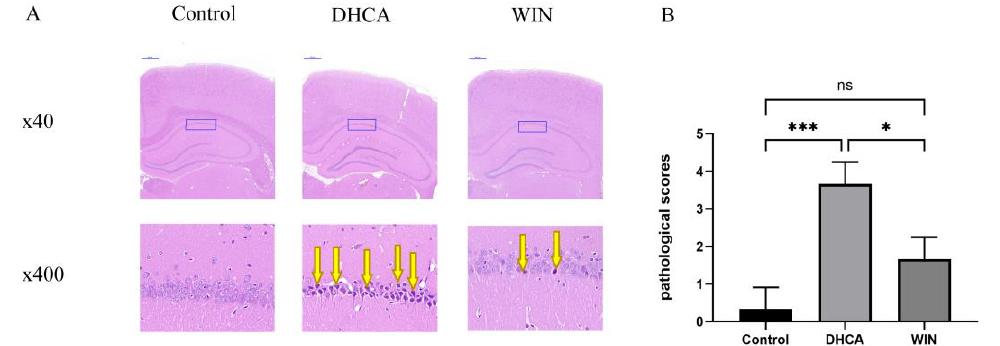
Figure 2. Hematoxylin – eosin staining showing the attenuation of hippocampal injury by WIN55, 212-2 in rats that underwent DHCA . ( A ) The blue boxes indicate the location of the hippocampus CA1 area. Neurons with pyknotic nuclei (yellow arrows) were decreased in the WIN55, 212-2-treated group. ( B ) Comparison of pathological scores of the hippocampus CA1. The region between the control, DHCA, and the WIN group ( n = 3). * p < 0.05, and *** p < 0.001. ns, no significance. DHCA, deep hypothermia circulatory arrest. CPB, cardiopulmonary bypass.